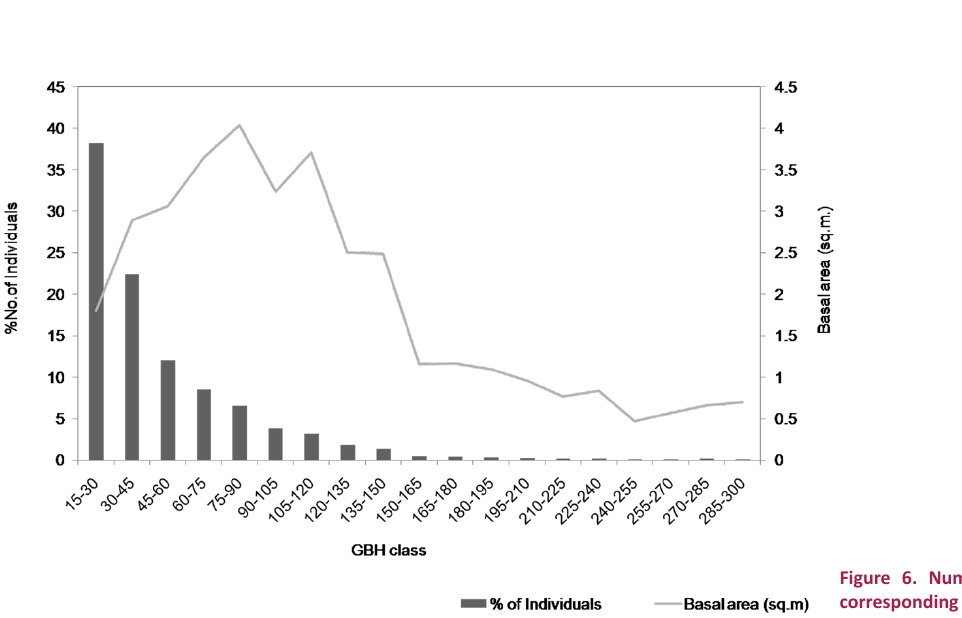
Figure 6. Number of individuals and corresponding basal area across